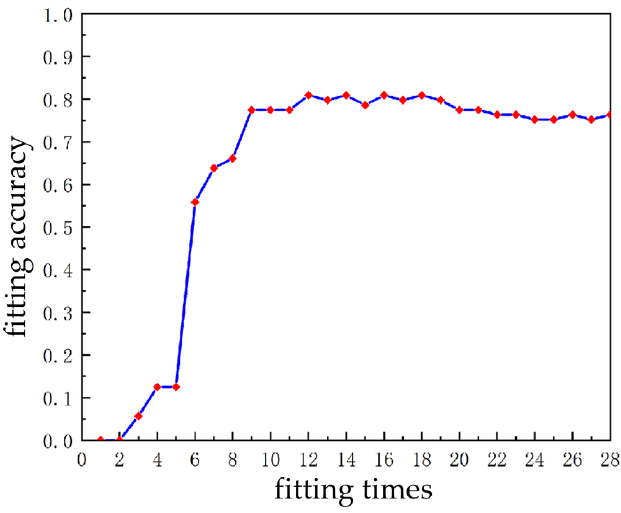
Figure 9. Fitting accuracy vs. fitting times.